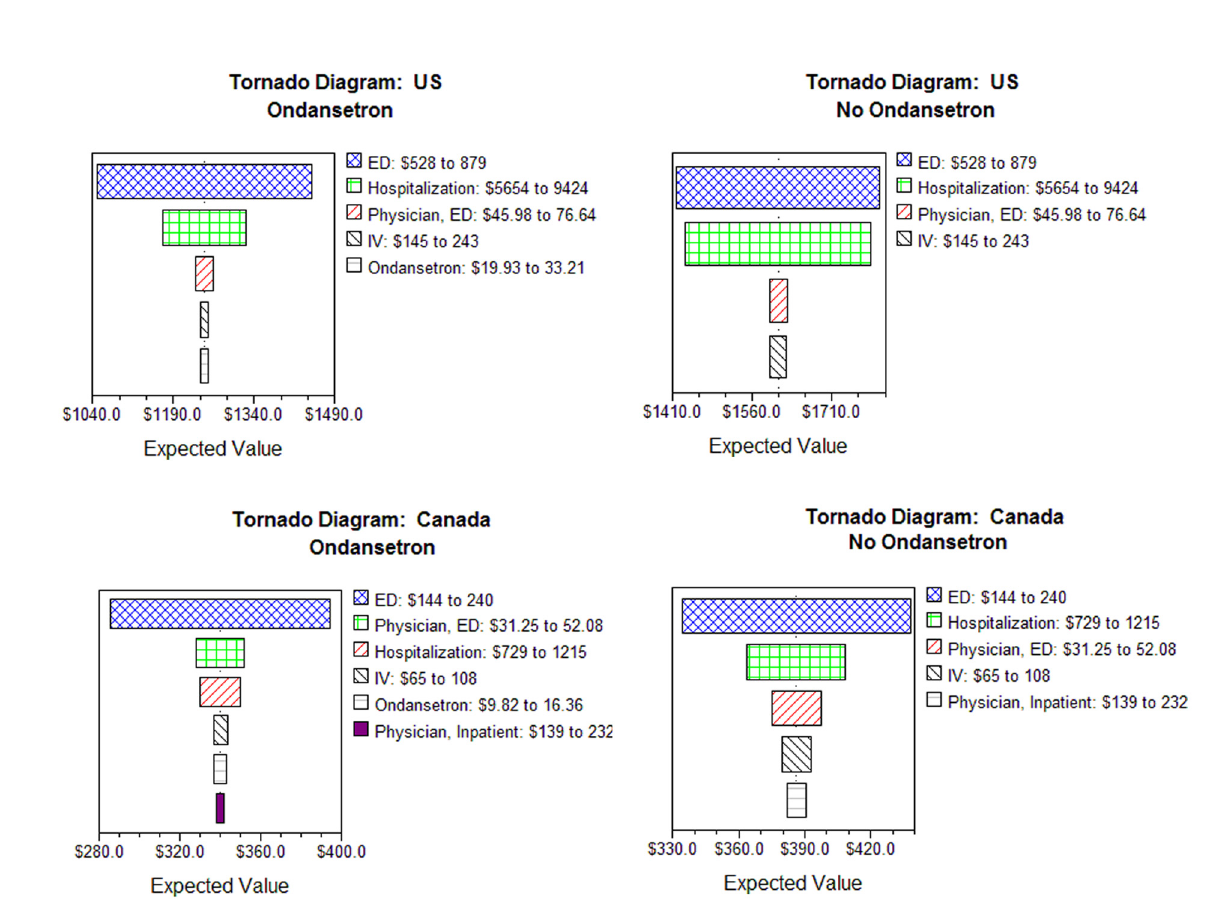
Figure 2. Tornado diagram showing the influence of changing values of any variable on per patient costs. Tornado diagram showing the influence of changing values of any variable on per patient costs when other variables remain at their base values. In the graph, variables are ranked on the basis of their influence (the most influential variable is on the top). Only variables that had more than 1% effect in the expected value were included. IV, intravenous.